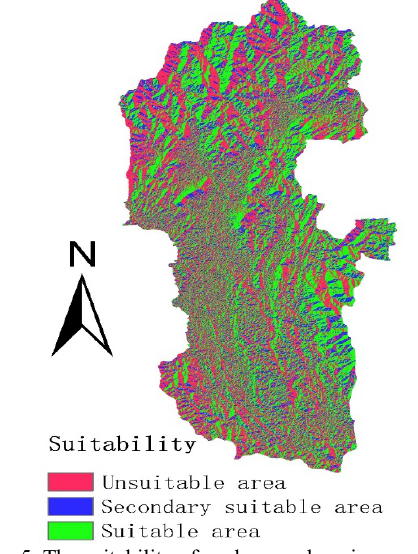
Figure 5. The suitability of ecology and environment about the development of tourism resources in Lijiang River